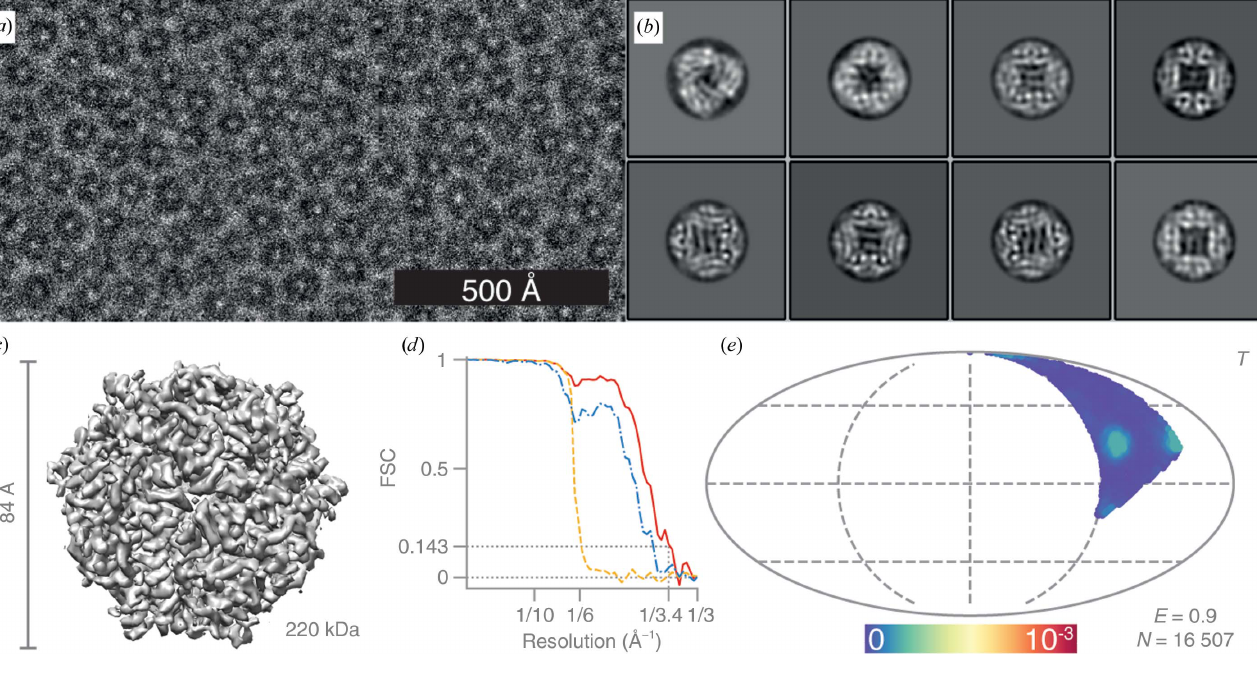
Figure 5 Structure of DPS determined at 100 keV. ( a ) Typical micrograph of DPS after motion correction. Contrast is adjusted to (cid:8) 3 (cid:3) from the mean intensity. ( b ) 2D class averages. ( c ) Sharpened masked 3D reconstruction of DPS from N = 16 507 particles with tetrahedral ( T ) symmetry. ( d ) Gold-standard FSC plot corresponding to the calculated map, showing the correlation between the phase-randomized (yellow), unmasked (blue) and masked (red) half-maps. The plot terminates at the Nyquist frequency. ( e ) Orientation distribution of the DPS particles contributing to the final reconstruction (Mollweide projection). All Euler angles are assigned within one asymmetric subunit for the tetrahedrally ( T ) symmetric particle. The colour scale (linear) corresponds to the normalized density of views (blue, low; red, high). E = 0.9 is the efficiency of the orientation distribution, indicating nearly uniform sampling of the particle views.